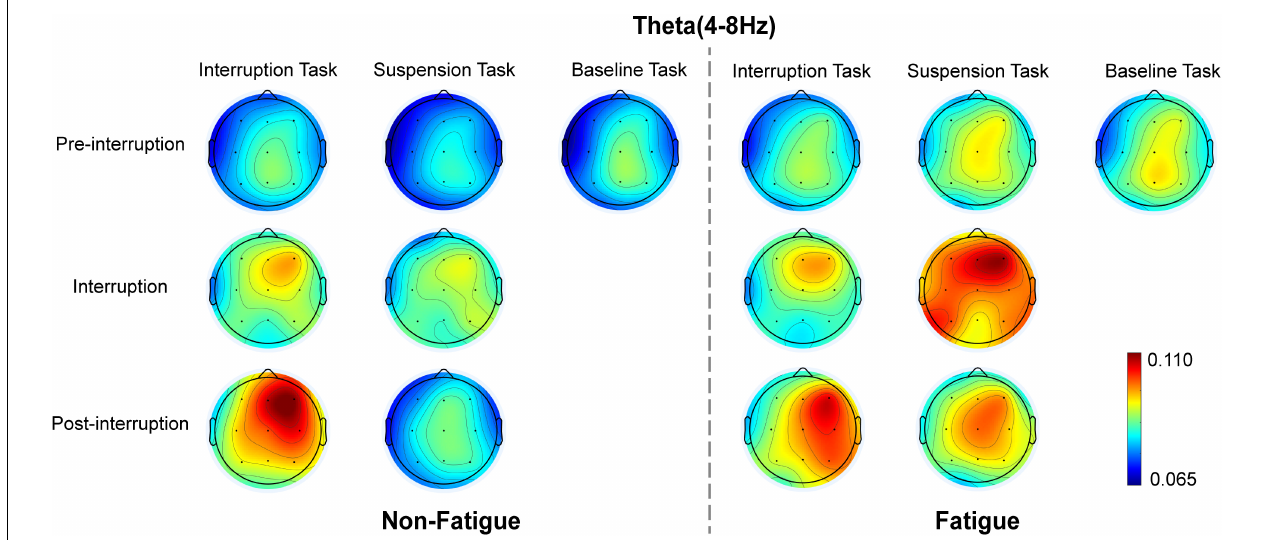
FIGURE 8 | Topographic representation of the grand average of the relative theta energy in various